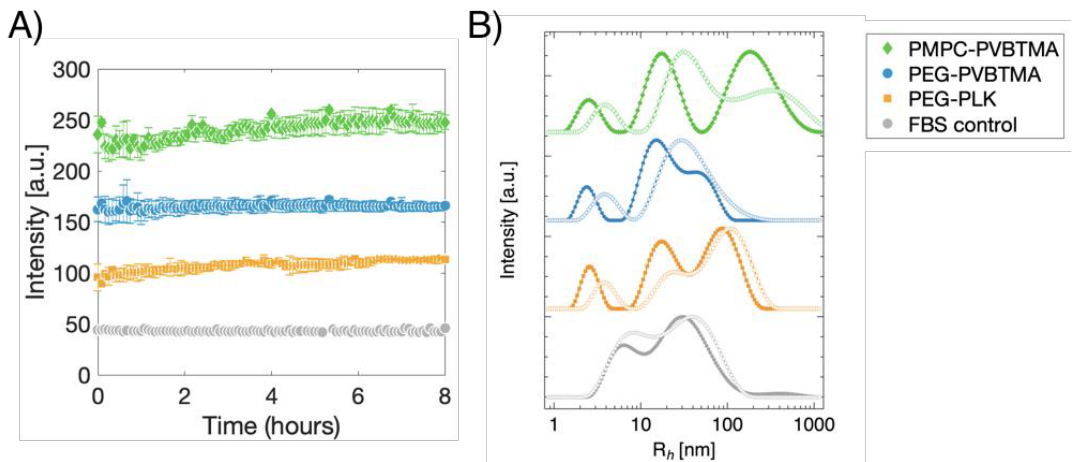
Figure 7. ( A ) Total light scattering intensity at 90° angle over 8 h of 100% fetal bovine serum (FBS) (gray circles) and 1:5 dilution of PEG 10K -PLK 93 (orange squares), PEG 10K -PVBTMA 100 (blue circles), and PMPC 10K -PVBTMA 97 (green diamonds) micelles with 100% FBS. Data points and error bars denote the average and standard deviation of 2 replicates; intensity is scaled for clarity; ( B ) apparent size hydrodynamic radius ( R h ) distribution of respective micelles at 1 h (solid markers) and 10 h (open markers), analyzed by REPES analysis at 90°. Intensity is scaled for clarity.